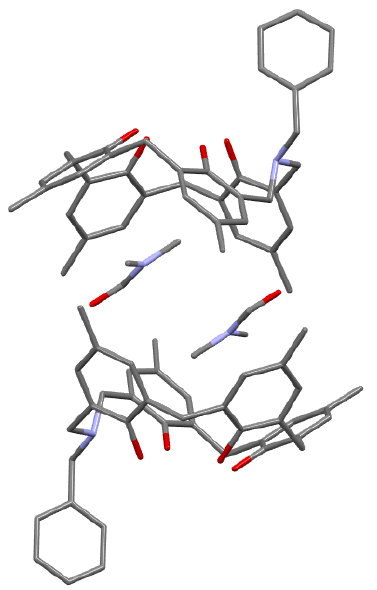
Figure 7. DMF inclusion capsule by p -me- N -benzyl-azacalix[3.1.1.1]arene. In metal complexes, lanthanide (Yb 3+ and Nd 3+ ) and uranyl ion complexes were